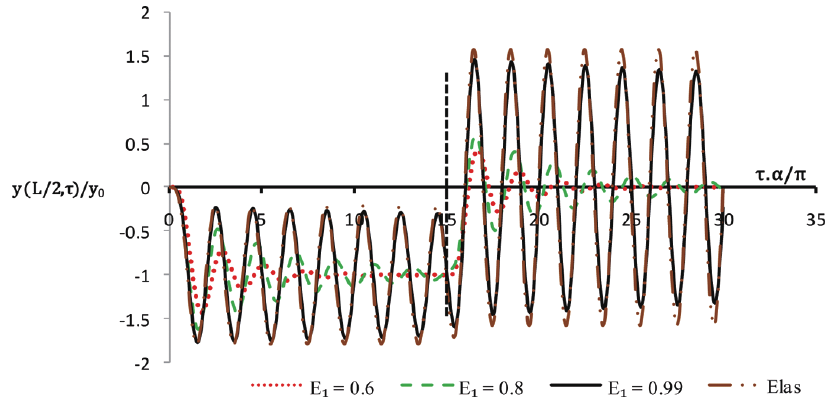
Fig. 10. DLF in terms of τ · α/π for α = 1, K = 1 for Elastic(Elas) case K is in fi nity and E1 = 1.